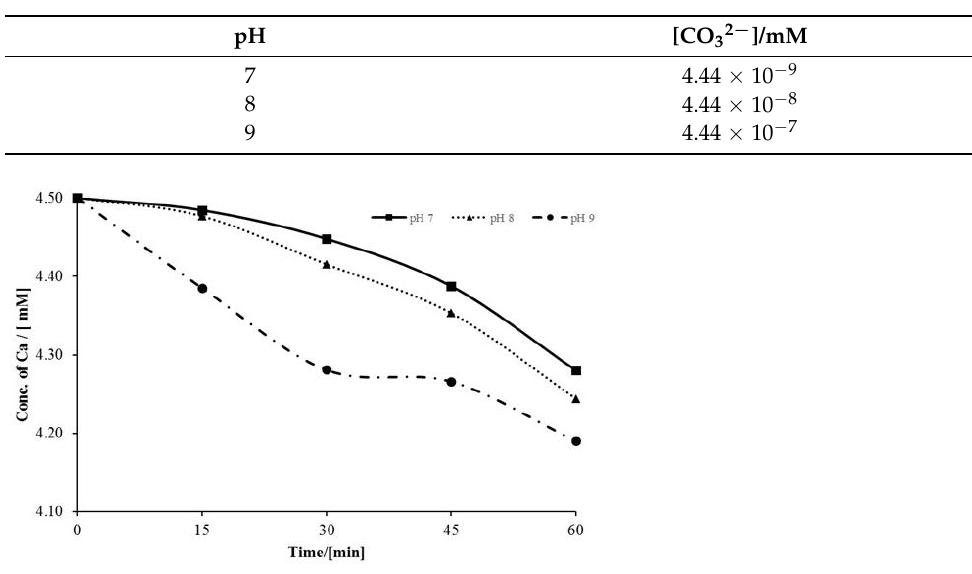
Table 1. Effect of pH on carbonate concentration at 9.5 mM bicarbonate solution.